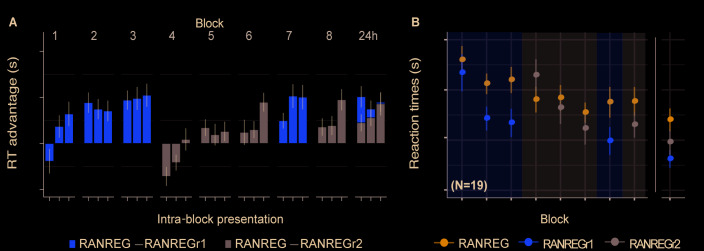
Experiment 3.(A) RT advantage for each intra-block presentation. Plotted values correspond to the RT advantage of REGr for each intra-block presentation. RTs to the 1st, 2nd or 3rd intra-block presentations were averaged across the different REGr, and RTs to novel REG were averaged across trials which occurred at the beginning (first third), middle or end of each block. The RT advantage for a set of reoccurring patterns (REG1; yellow traces) was not affected by the presentation of another set of REGr (REGr2) in blocks 4–6. Error bars indicate 1 s.e.m. Note that the RT for REGr is computed based on three trials and the effects are therefore rather noisy. (B) RT across blocks with N = 19. The overall pattern was identical to that observed with N = 30 participants (reported in the main text). The RT advantage for the first set of REGr1 observed across the first three blocks [main effect of condition: F(1, 18) = 24.16, p < 0.001, ηp2 = 0.57; main effect of block: F(3, 54) = 11.47, p < 0.001, ηp2 = 0.39; condition by block interaction: F(3, 54) = 3.08, p = 0.035, ηp2 = 0.15] was not perturbed after the presentation of the second set of reoccurring sequences [RT advantage for RANREGr1 in block three vs. block 7: t(18) = .403, p = 0.691].